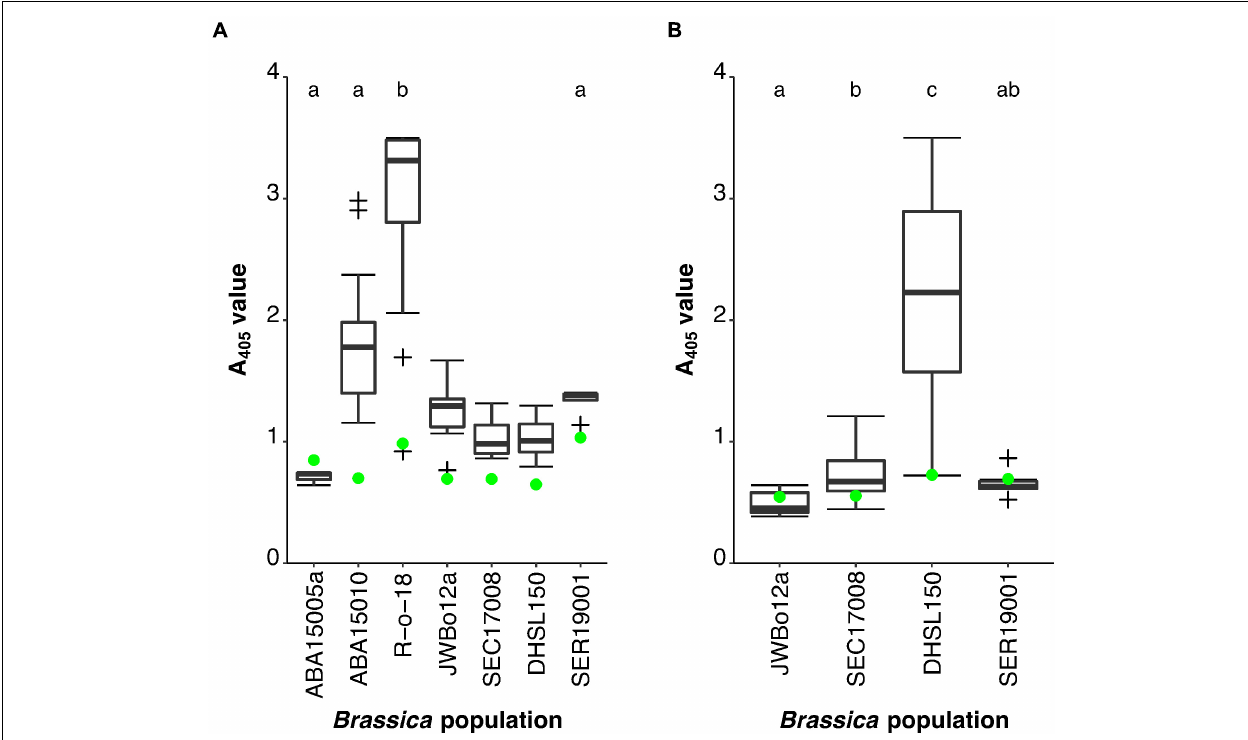
FIGURE 3 | Turnip yellows virus (TuYV) phenotyping of resynthesised allotetraploid AACC S 1 population SER19001 alongside TuYV-resistant and -susceptible B. rapa and B. oleracea lines. ABA15005a ( B. rapa ) ( n = 3) and JWBo12a ( B. oleracea ) ( n = 18) were the S 1 populations TuYV-resistant parental lines of SER19001 ( n = 5). R-o-18 ( B. rapa ) ( n = 18) and DHSL150 ( B. oleracea ) ( n = 12) were the TuYV-susceptible parental lines of the within-species mapping populations. ABA15010 ( B. rapa ) ( n = 17) and SEC17008 ( B. oleracea ) ( n = 18) were the F 1 populations. Two plants from each line were not challenged with TuYV and were used as healthy controls. The mean healthy control value for each population is indicated ( ). Populations with mean ranks not significantly different from one another are represented by the same lowercase letter (Dunn’s test with Bonferroni correction for multiple pairwise comparisons at significance level p = 0.05). (A) Enzyme-Linked (cid:32) Immunosorbent Assay (ELISA) A 405 values 4 weeks post TuYV challenge. The B. oleracea lines were not included in the statistical analysis at this time point. (B) ELISA A 405 values 11 weeks post TuYV challenge. Outliers are indicated by